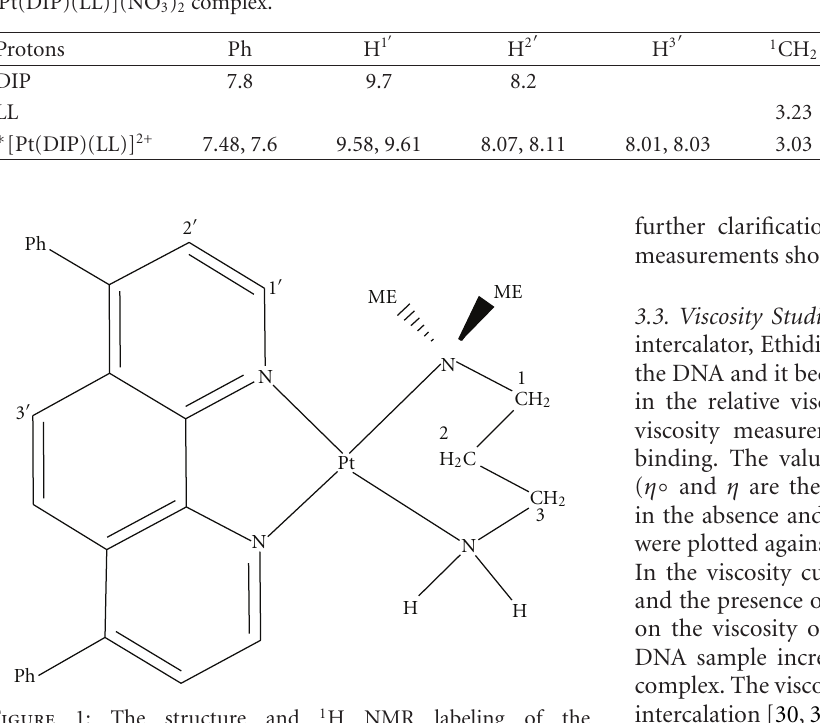
Figure 1: The structure and 1 H NMR labeling of the [Pt(DIP)(LL)](NO 3 ) 2